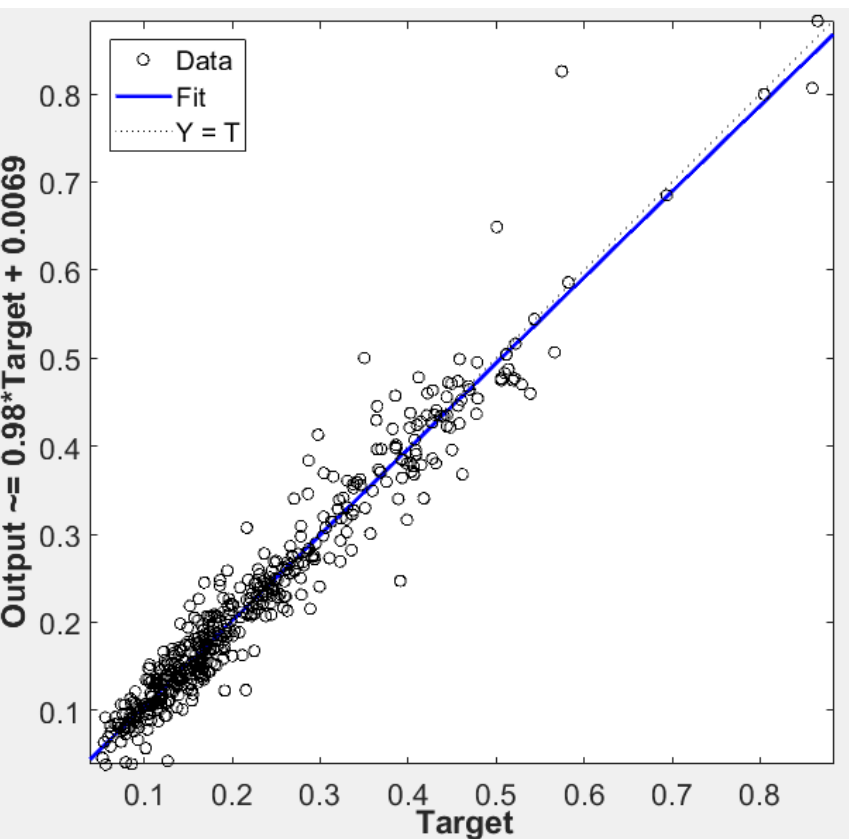
Figure 15. Regression plot for the validation of a NN model of P 0 with Δ t = 60 s step and ROI radius = 250 pixels.